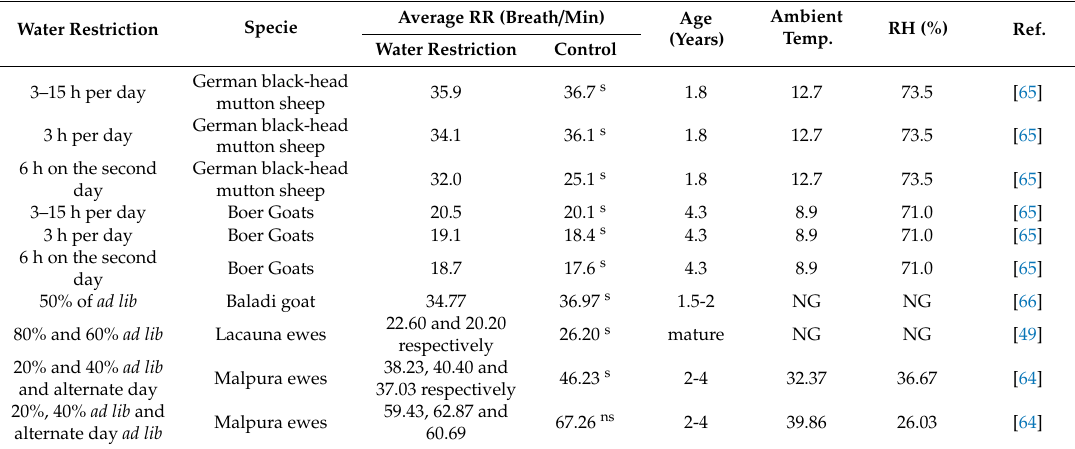
Table 3. E ff ect of water restriction regimen on respiratory rate in small